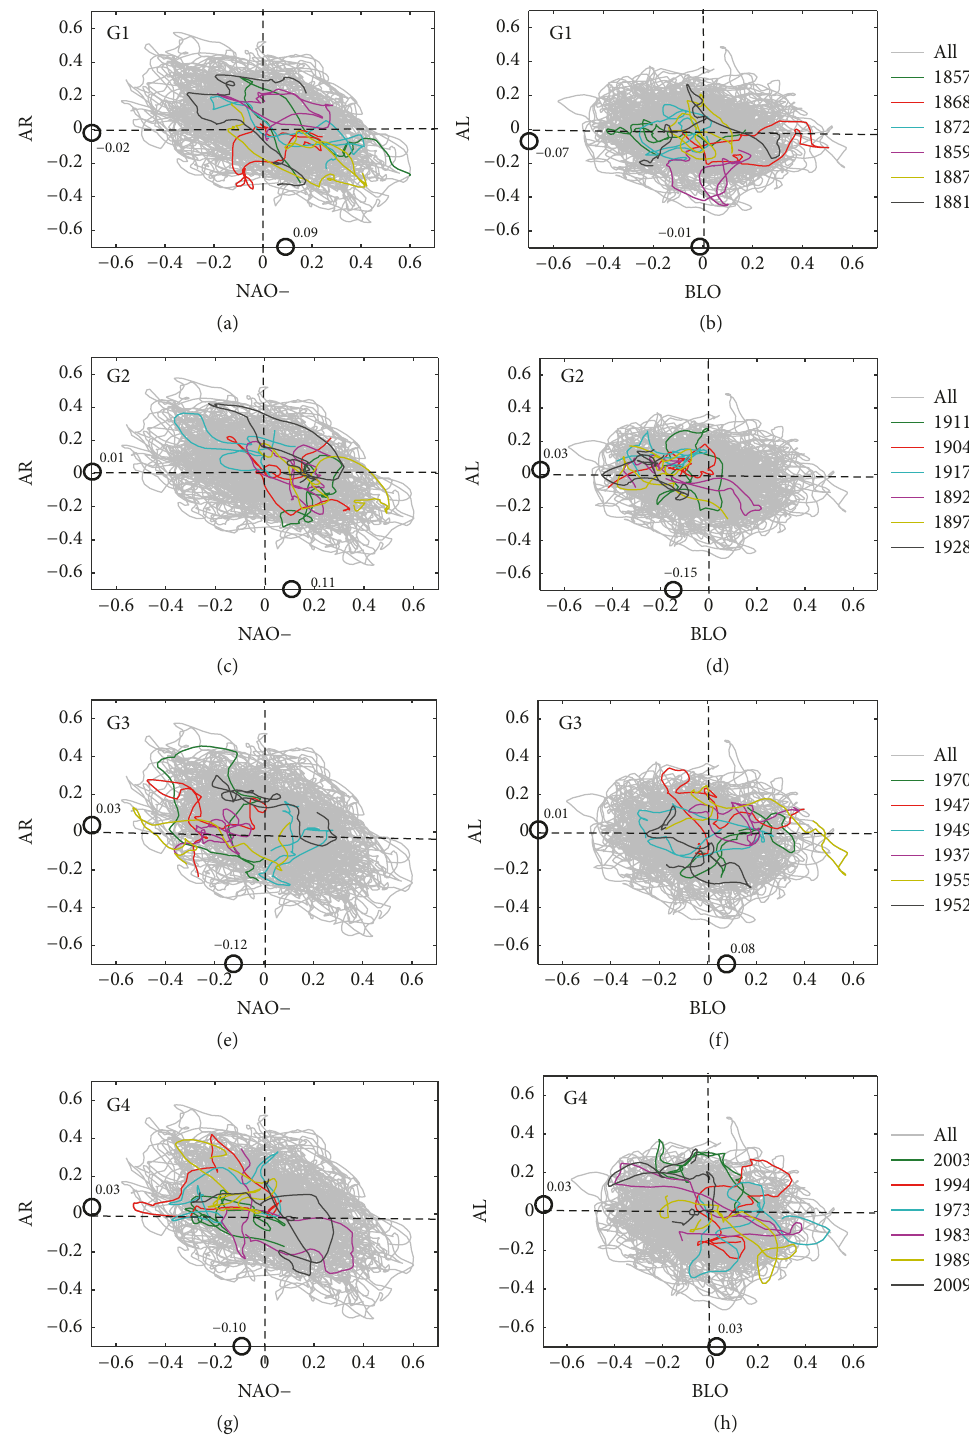
Figure 3: Dynamical representation of the warmest summers. Correlations of daily SLP fields and NAO − ( 𝑥 -axis), AR ( 𝑦 -axis) (top) and AL, BLO (bottom) weather regimes for the 4 groups of summers. Warmest summers are colored as in the legend with light grey lines representing all data. Average correlations of warmest summers with respect to the NAO − weather regimes (black circle on 𝑥 -axis). A moving average filter of 30-day window was applied to the warmest summers for better